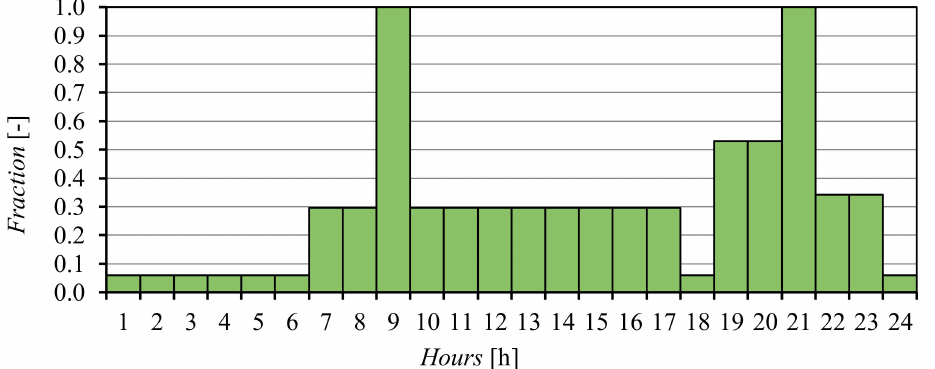
Figure 9. Daily schedule of using sanitary facilities in the bathroom.